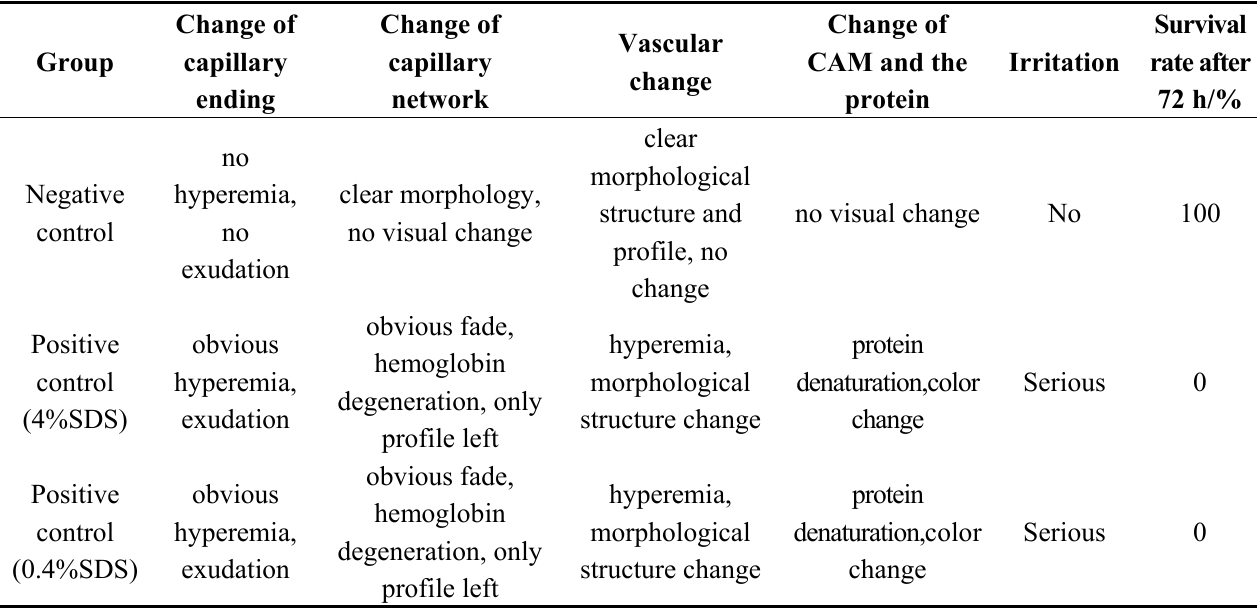
Table 1. Results of the morphological observation and the survival rate of chick embryos in CAM